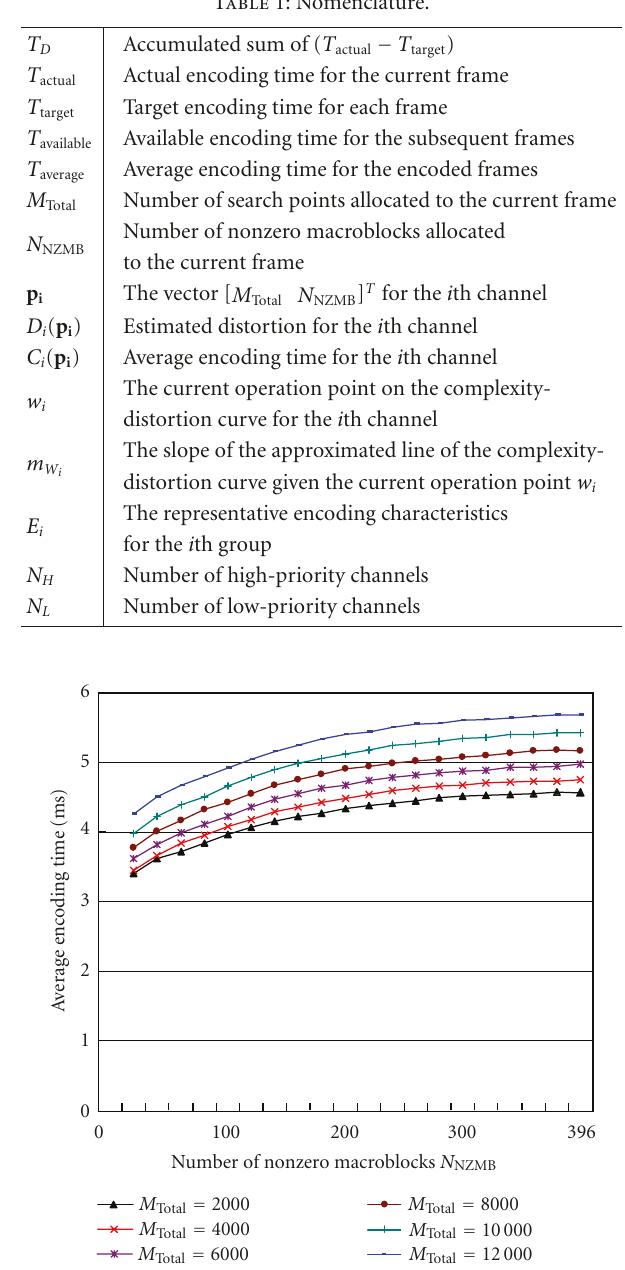
Figure 3: The average encoding time of the Football sequence for di ff erent numbers of nonzero macroblocks ( N NZMB ) and SAD oper- ations ( M Total